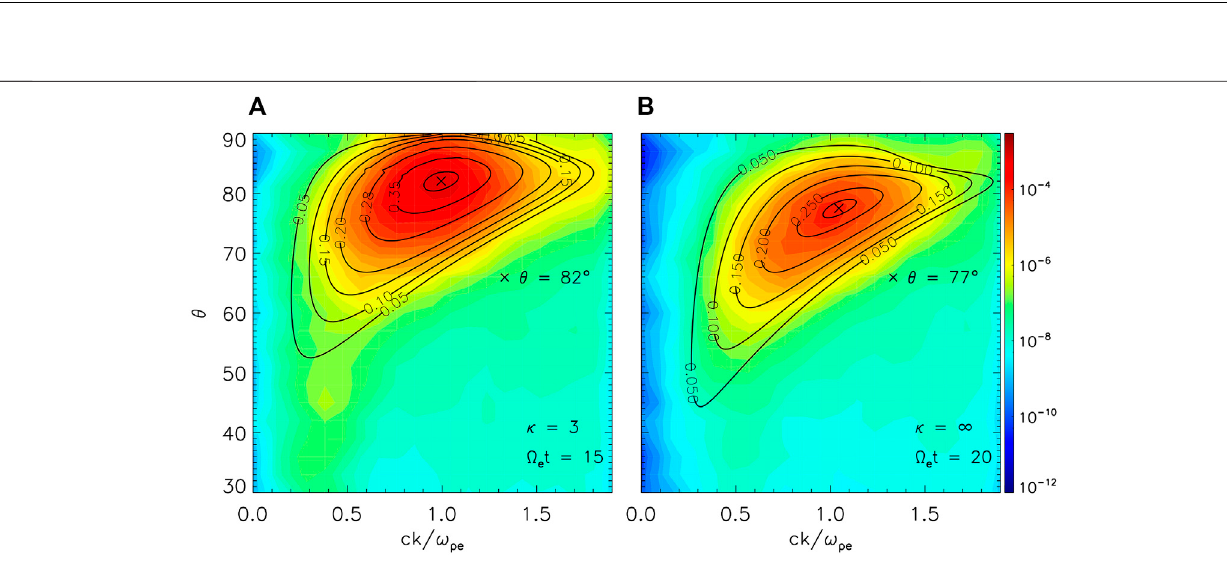
Frontiers in Astronomy and Space Sciences |